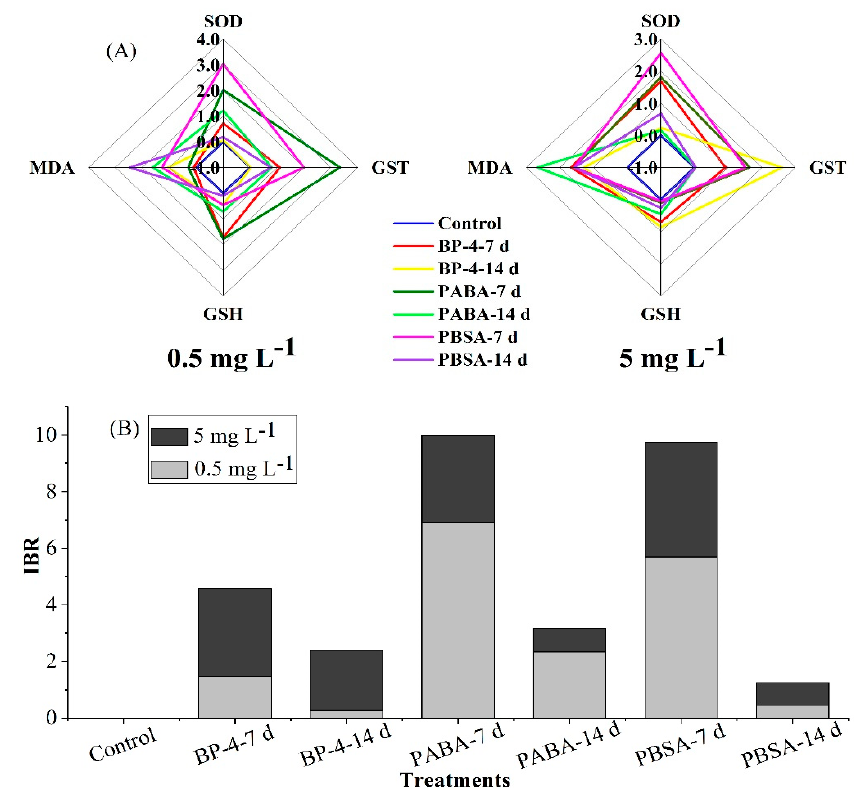
Figure 3. Biomarker star plots ( A ) and the calculated IBR values ( B ) of all biochemical parameters measured in zebrafish liver after exposure to BP-4, PABA, or PBSA (0.5 and 5 mg L − 1 ) for 7 and 14 days.